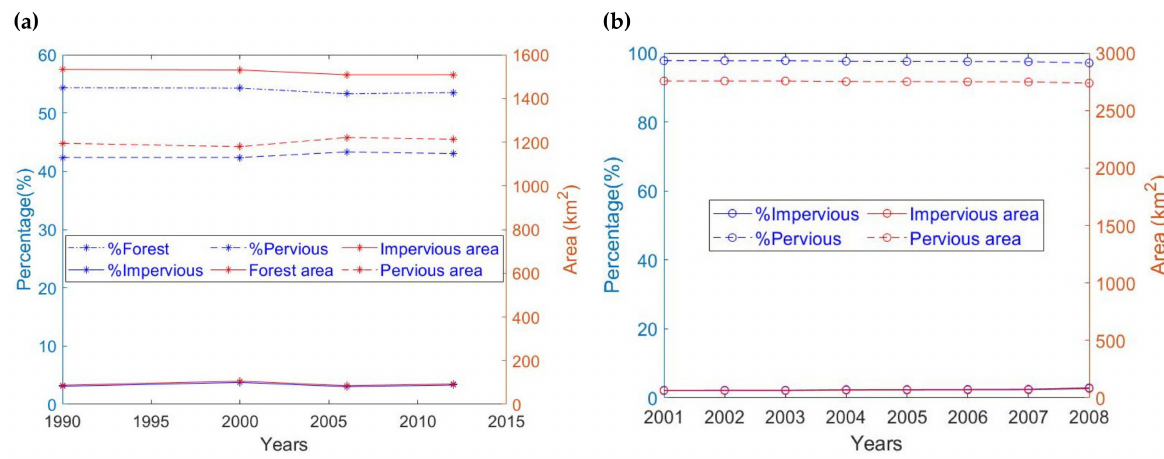
Figure 2. Land cover evolution in Karasu basin ( a ) CORINE ( b )